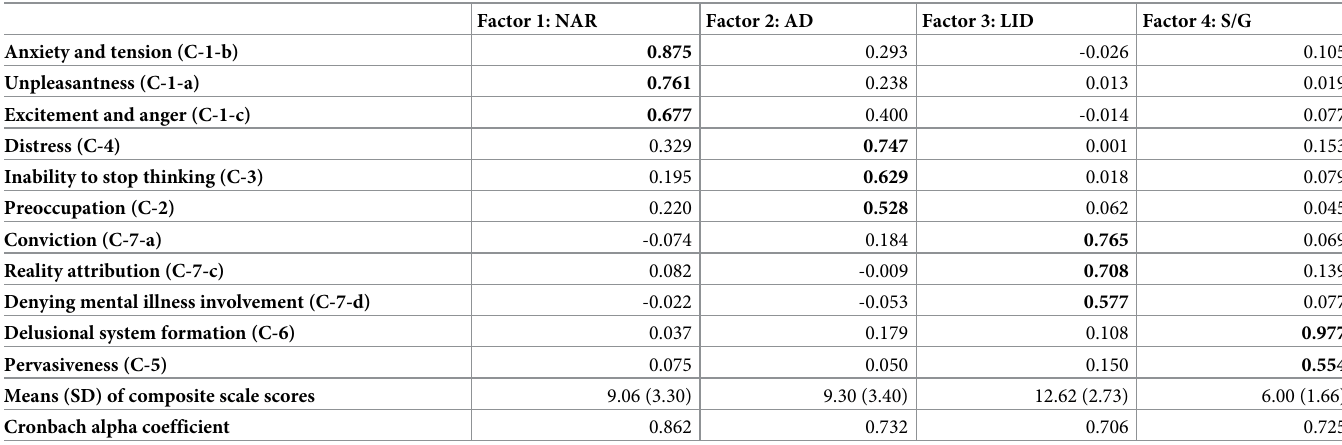
Table 3. The factor structure, means (SDs) and internal consistency of composite scales for DOAI Section C: Response and judgment items. Factor 1: